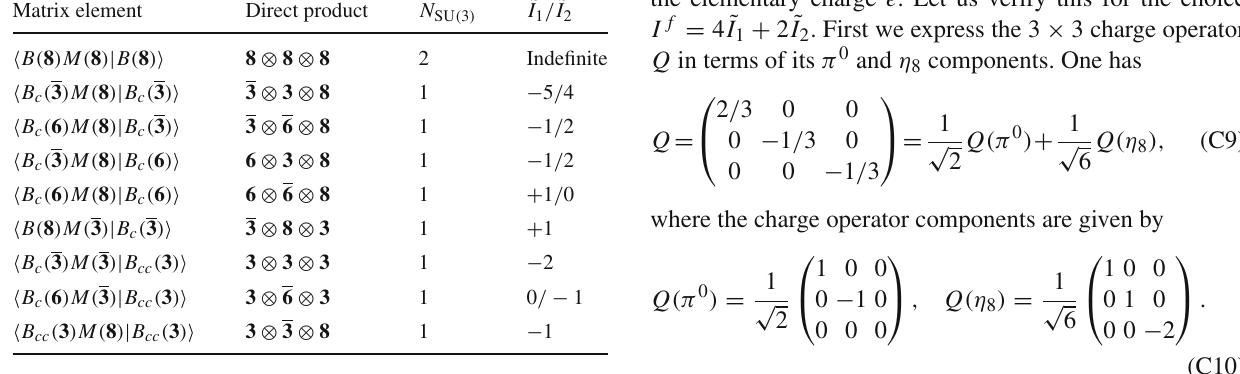
Table 17 SU(3) properties of the strong transition matrix elements Matrix